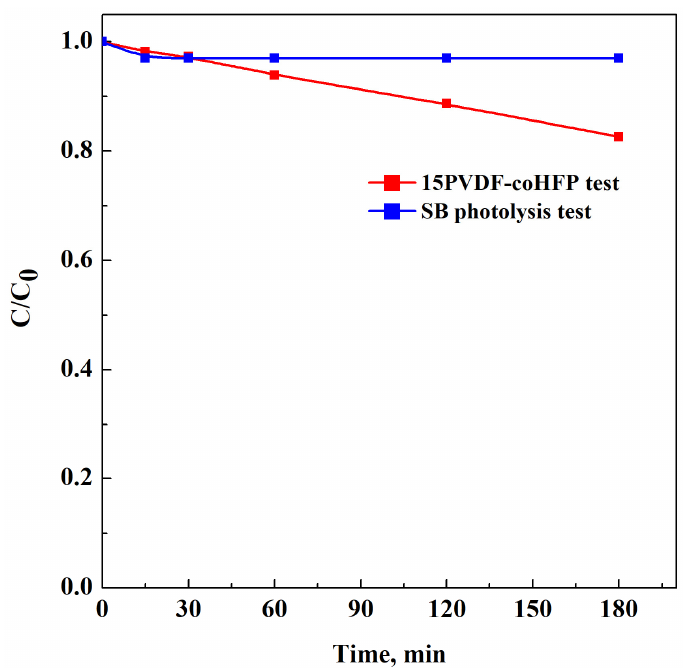
Figure 6. SB removal using 15PVDF-coHFP membrane under UV light (red line) and SB photolysis test (blue line).